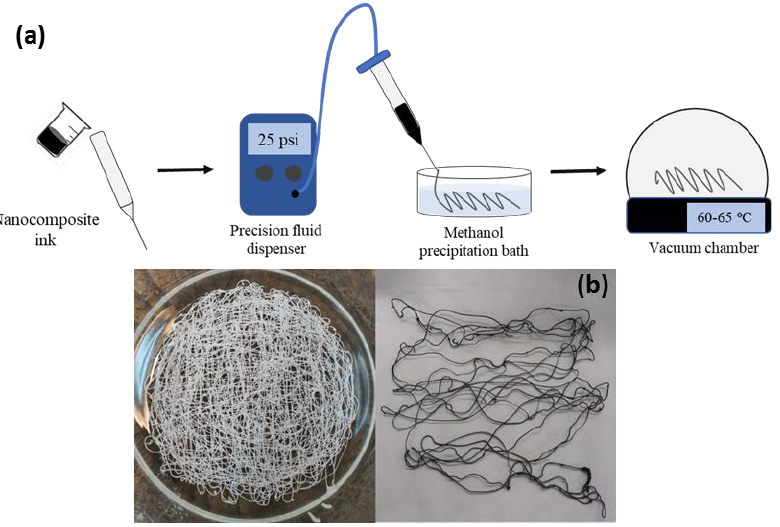
Figure 3. ( a ) Scheme of dry – jet wet – spinning method using a precision fluid dispenser and manu- ally creating the fibers. ( b ) Photograph of PET (left) and PET/graphene fibers with a loading of 4 wt.% prepared by dry – jet wet spinning.